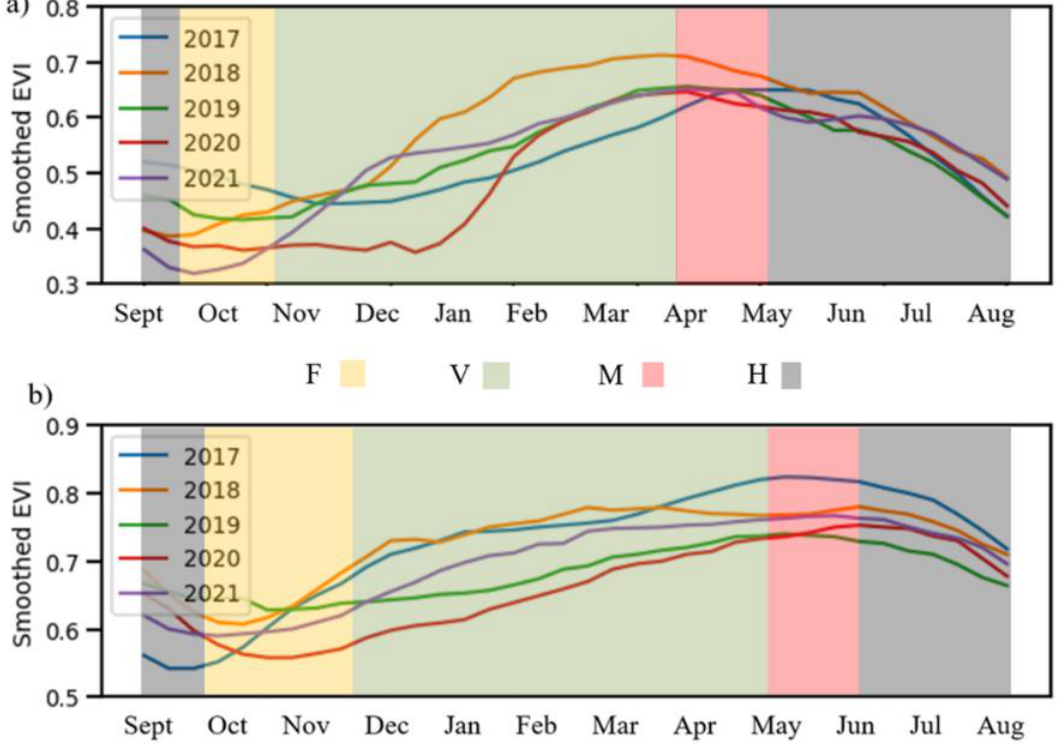
Figure 7. Seasonal variations in EVI trends within the study period (2017 – 2021) in the ( a ) Bundaberg and ( b ) Renmark avocado farms.